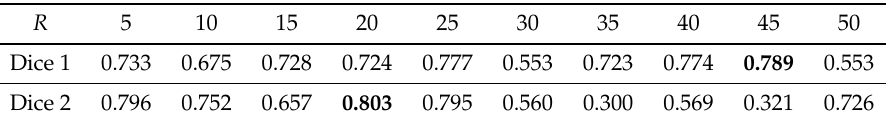
Table 3. Pearson’s correlation coefficient for the whole dataset from Dice 1 and Dice 2. The best values are marked.